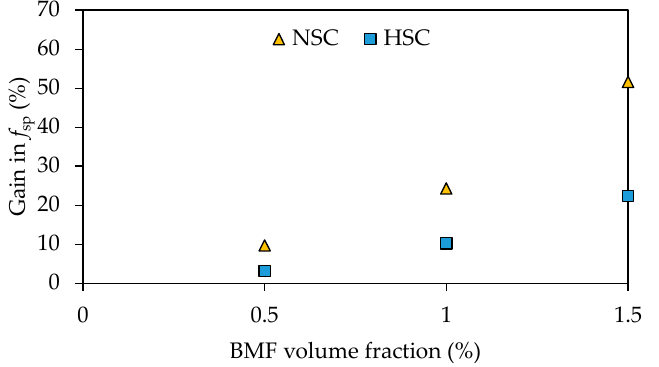
Figure 10. Splitting tensile strength gain versus BMF volume fraction relationship.